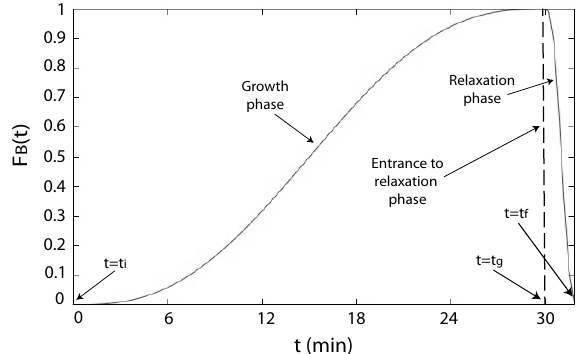
Figure 3. Function F B (t) for the modeling of geomagnetic events and their different phases for t i = 0min, t g = 30min, t r = t f = 35min and w 1 = w 2 = 0, w 3 = 10, w 4 = − 15, and w 5 = 6.